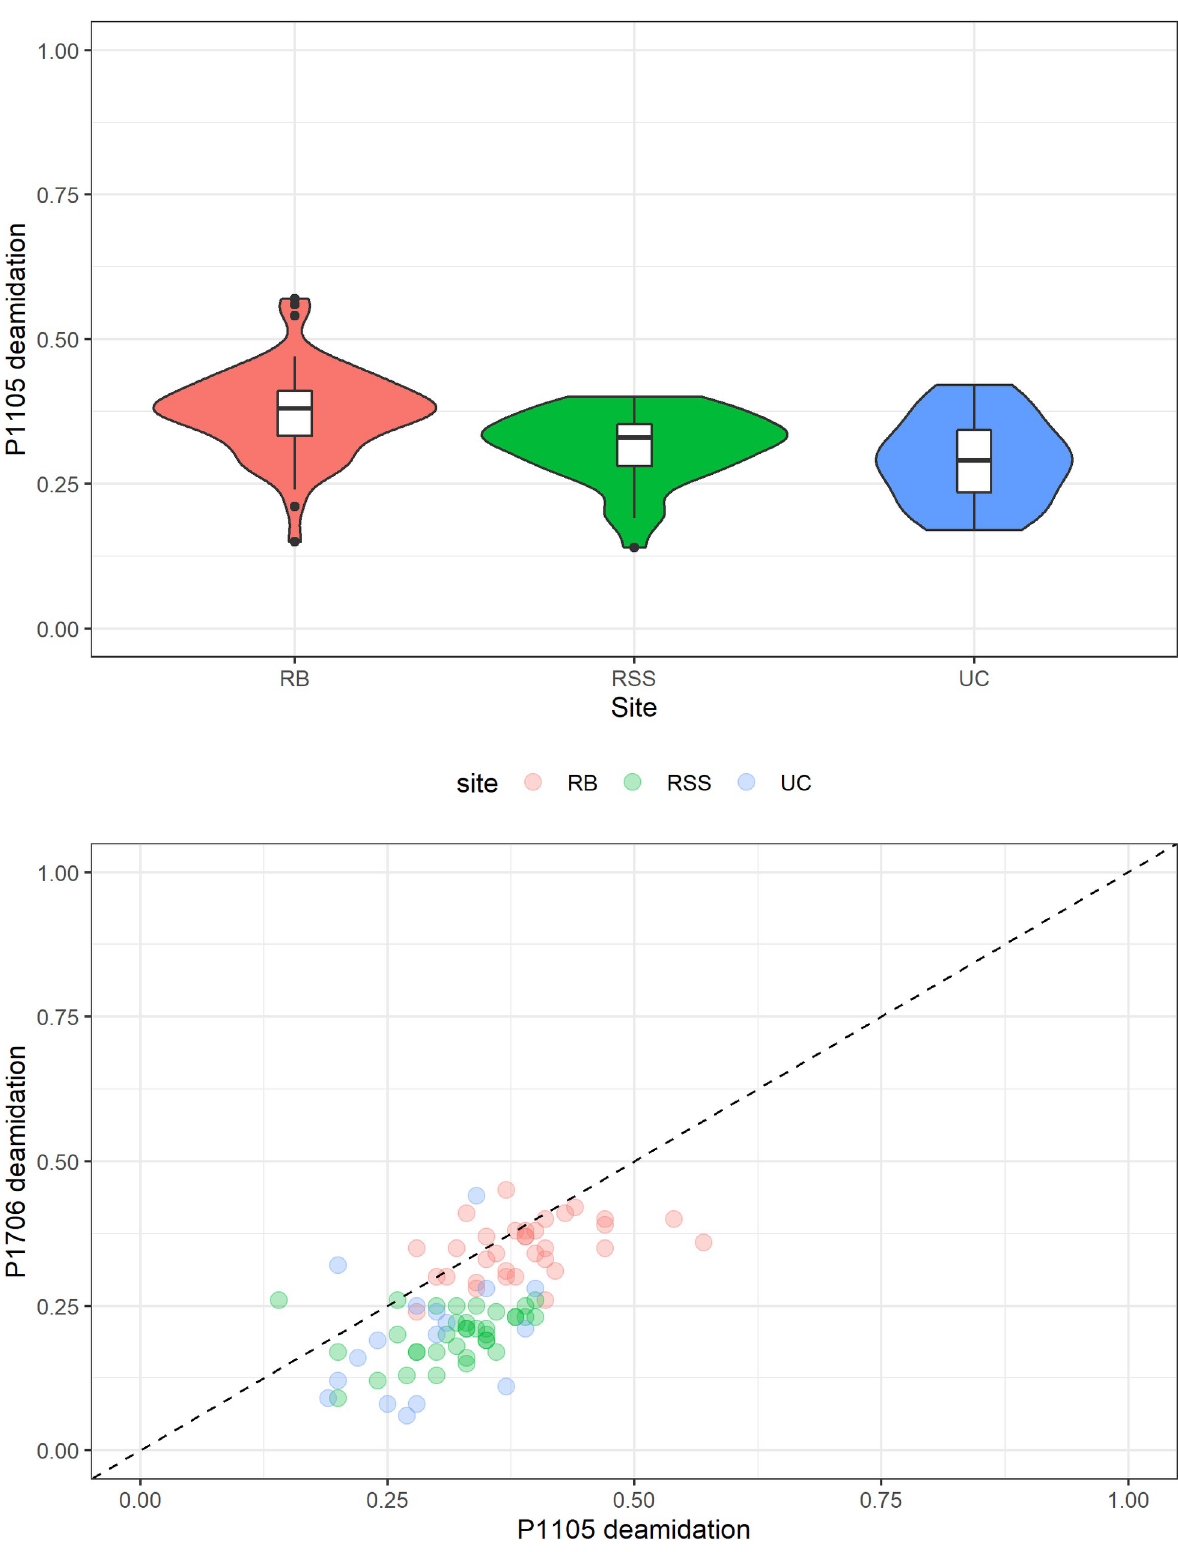
Fig 6. Violin plot and biplot of glutamine deamidation ratios. %Gln of P1105 for RB (Riparo del Broion), RSS (Roccia San Sebastiano cave) and UC (Uluzzo C Rock Shelter) and biplot of %Gln of P1105 and %Gln of P1706 for all the analysed contexts, the dashed line is the 1:1 ratio.